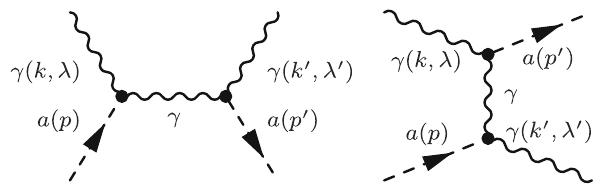
Fig. 1 Feynman diagrams for scattering of photon on